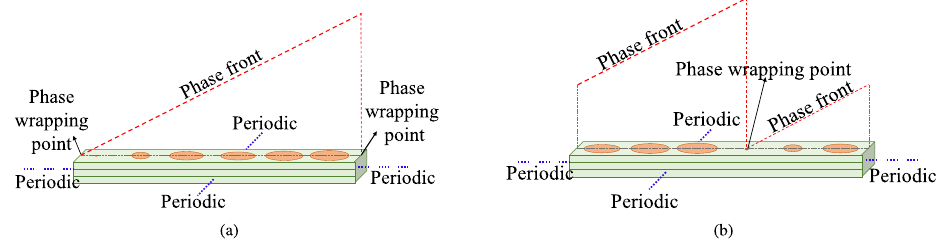
Figure 5. Supercells for 30 ◦ beam-tilt with ( a ) phase wrapping at the edges, ( b ) with phase wrapping somewhere in the